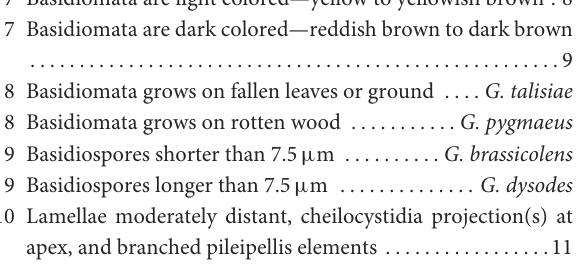
7 Basidiomata are light colored—yellow to yellowish brown . 8 7 Basidiomata are dark colored—reddish brown to dark brown